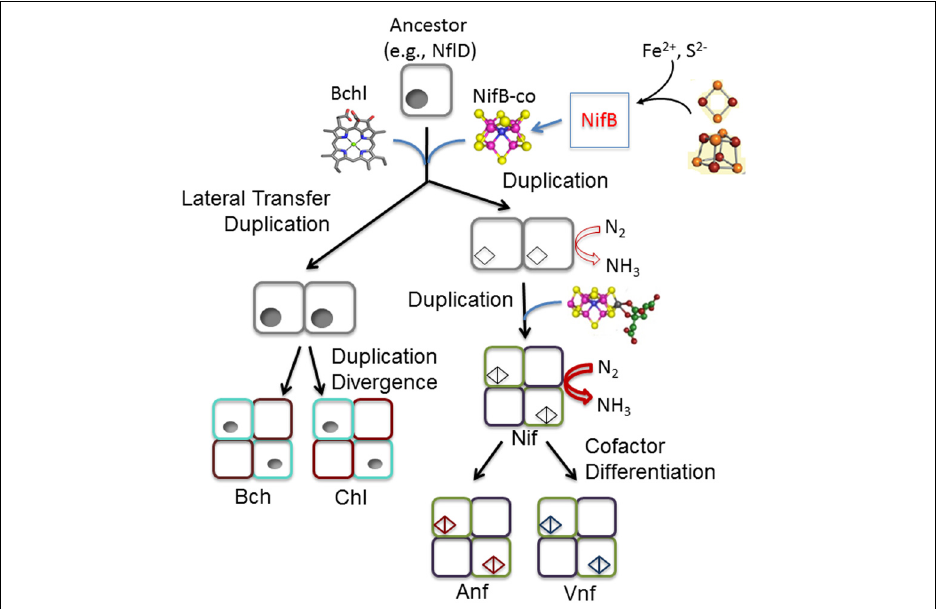
FIGURE 3 | Hypothetical scheme depicting the evolution of nitrogenase from its protein ancestor. Parsimony suggests that the likely ancestor of these protein complexes was a NflD-like protein present in an ancestral methanogen. The movement of an ancestor of a NflD-like protein to anoxygenic phototrophs, and the diversification of this protein into BchN, would necessitate lateral gene transfer followed by a duplication event. In contrast, vertical inheritance of a duplicated NflD ancestor in a methanogen can account for proto NifD. The diversification of the duplicated NflD like ancestor into a proto homodimeric NifD (i.e., protonitrogenase) is presumed to have been precipitated by interaction with an ancestor of the radical SAM protein NifB, which in extant biology catalyzes the formation of the FeMo-co precursor, NifB-co, from simple FeS clusters. Here, NifB-co or the like could have serendipitously been inserted in the open active site cavity presumed to be present in the protonitrogenase ancestor (e.g., BchN- or NflD-like) conferring the ability to perhaps catalyze a low level of N 2 reduction. A second duplication of nifD and the subsequent diverisification of this gene (loss of FeMo-co binding site) led to nifK . The later bicistronic duplication of nifDK and subsequent diversification of these genes to nifEN yielded the ability to further mature biosynthetic intermediates into FeMo-co. In this depiction, metal cofactor binding sites within proteins are indicated by lobes whereas those that likely bind organic cofactors (e.g., protochlorophyllide) are indicated by circles. Open lobes depict sites where a cluster similar to NifB-co may have been bound by a